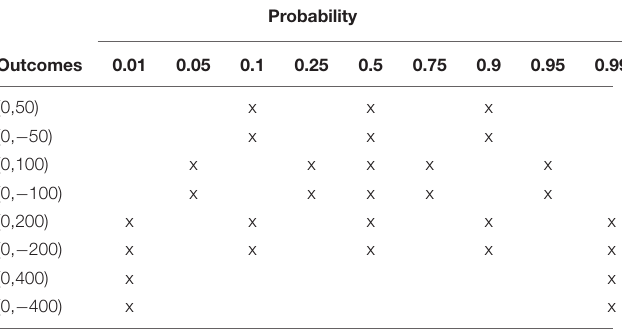
TABLE 1 | Gain and Loss gambles (spots with ‘x’ refers to a gamble with the outcome value in the respective row and probability in the respective column) used in the experiment (adopted from Tversky and Kahneman, 1992) (Probability of the second outcome is given in the table. E.g., 99% chance of losing 400 in the bottom right gamble).